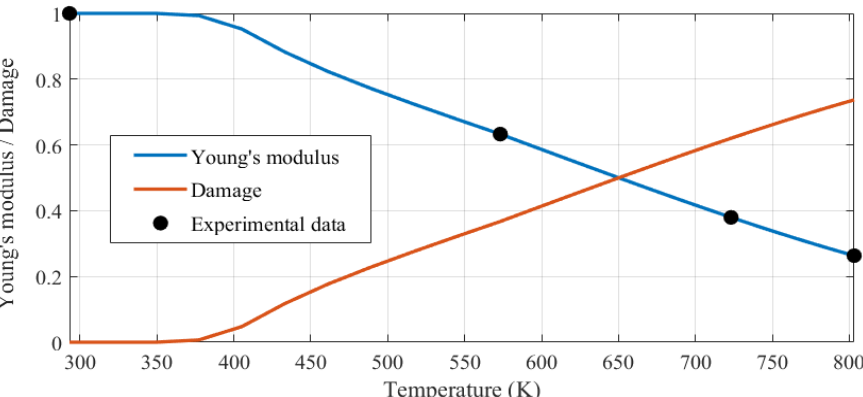
Figure 14. Evolution of Young's modulus and damage to concrete with